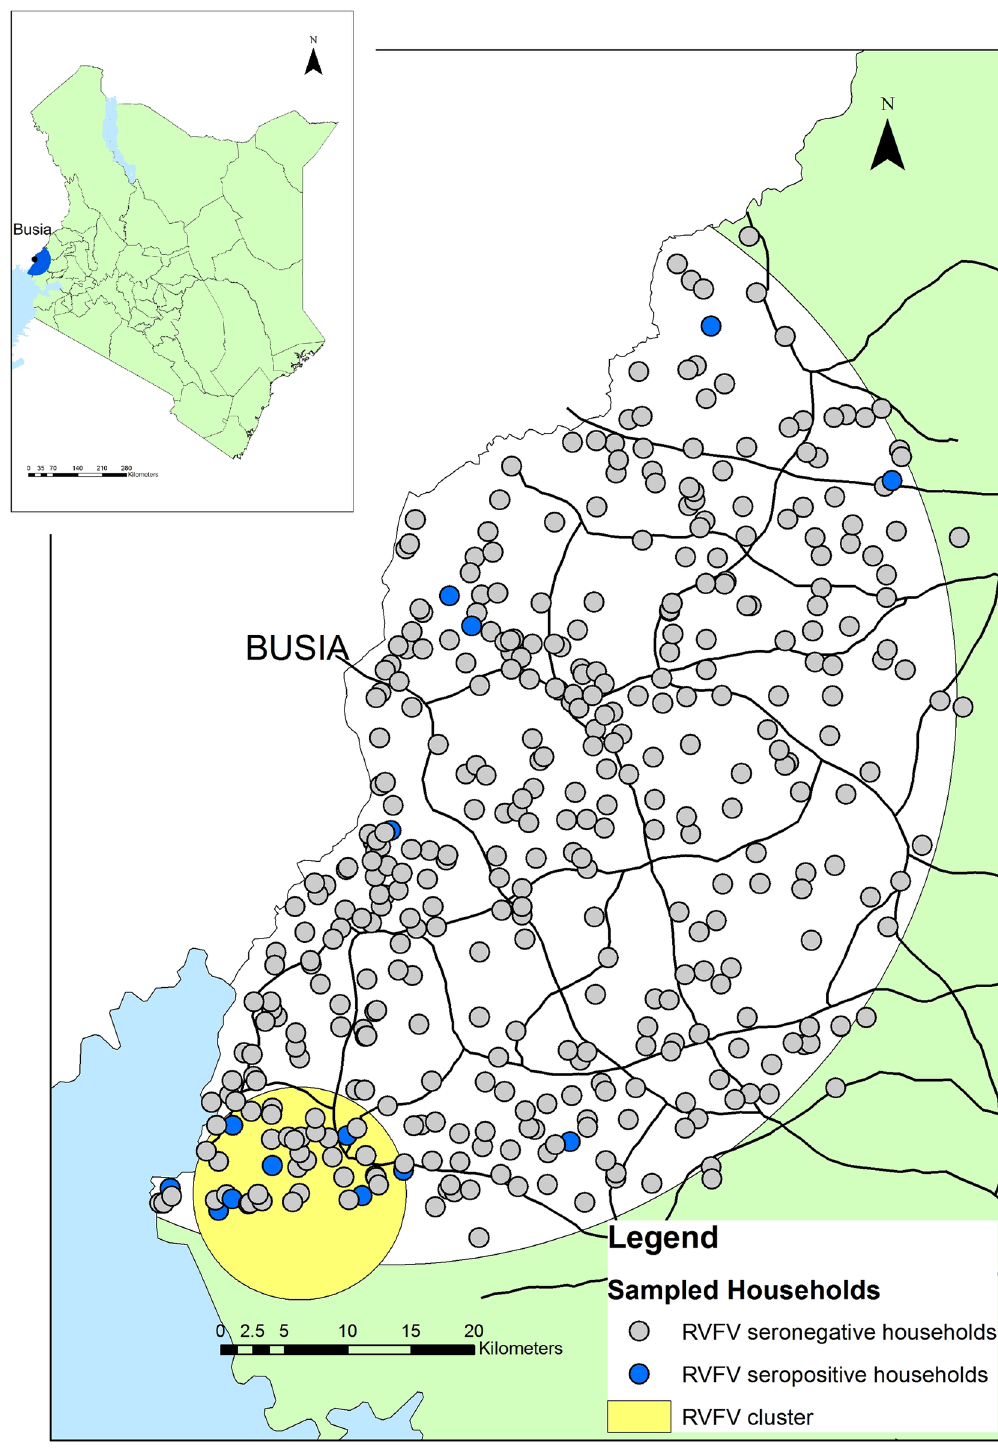
Fig 2. Map of the distribution of RVFV seropositive and seronegative homesteads and the statistically significant (p < 0.05)cluster of elevated relative risk for homestead level RVFV seropositivity.